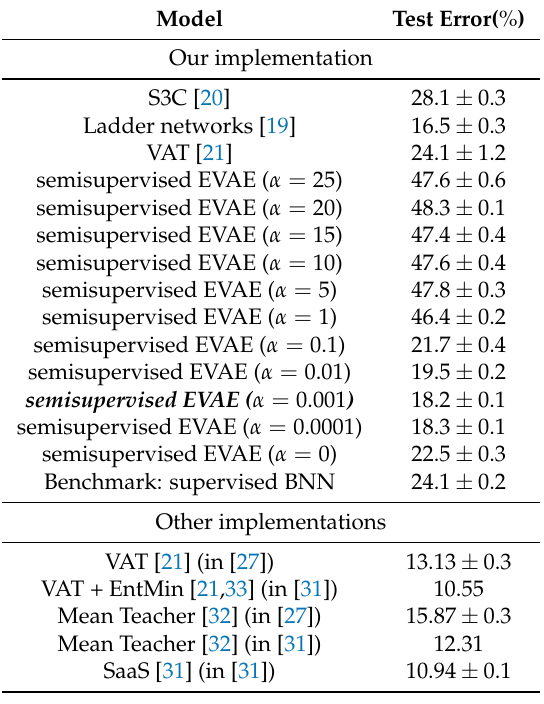
Table 3. Test error rates on CIFAR-10(4k) dataset. Note: S3C, spike-and-slab sparse coding; VAT, virtual adversarial training; SaaS, Speed as a Supervisor; BNN, Bayesian neural network. Model Test Error( %